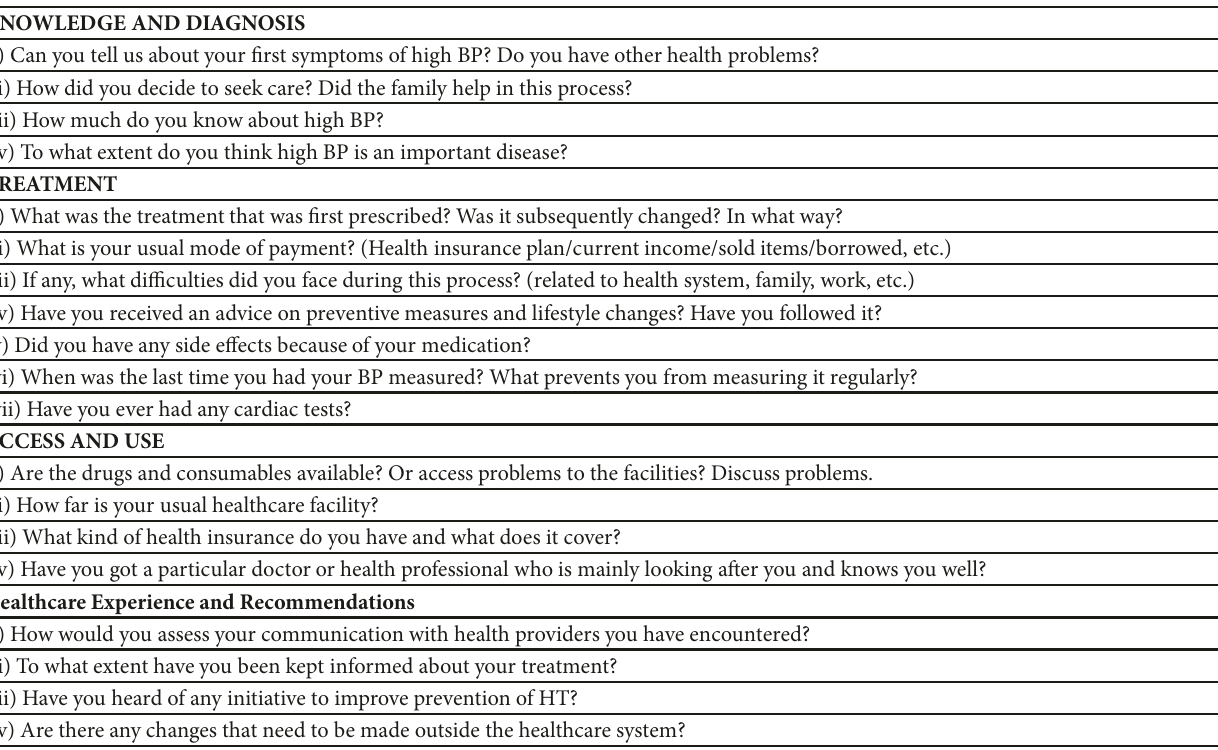
Table 1: Summary interview guide.